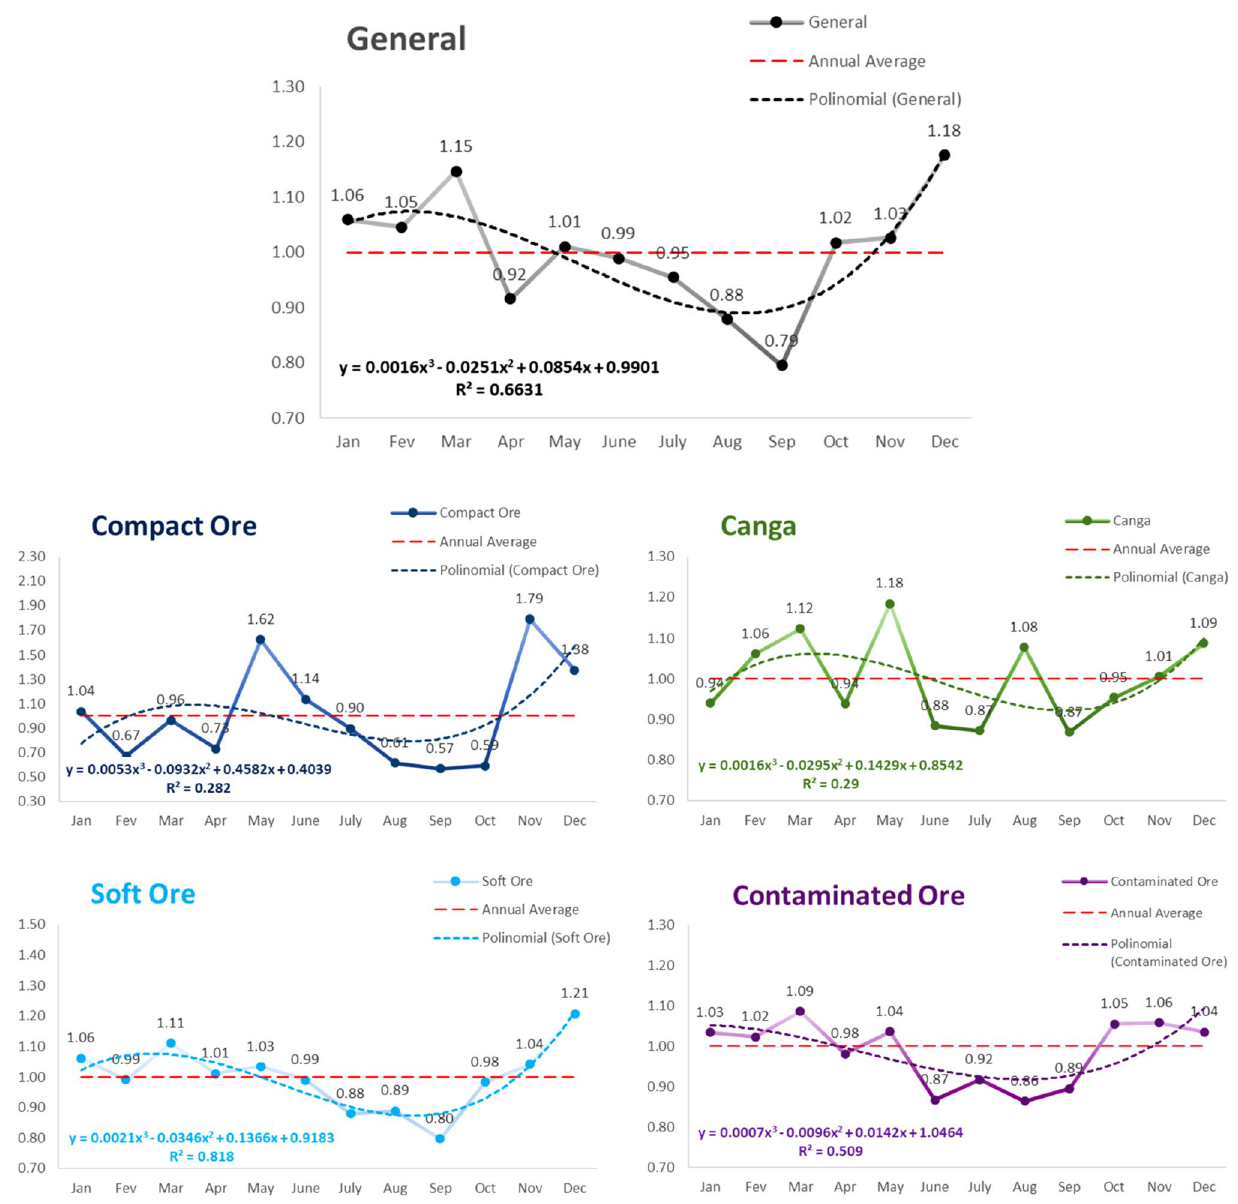
Fig. 12 Third-order polynomial regression graphs and equations to correct the seasonal effect per ore type. General stands for all samples. Variable x in the equation means the month of the